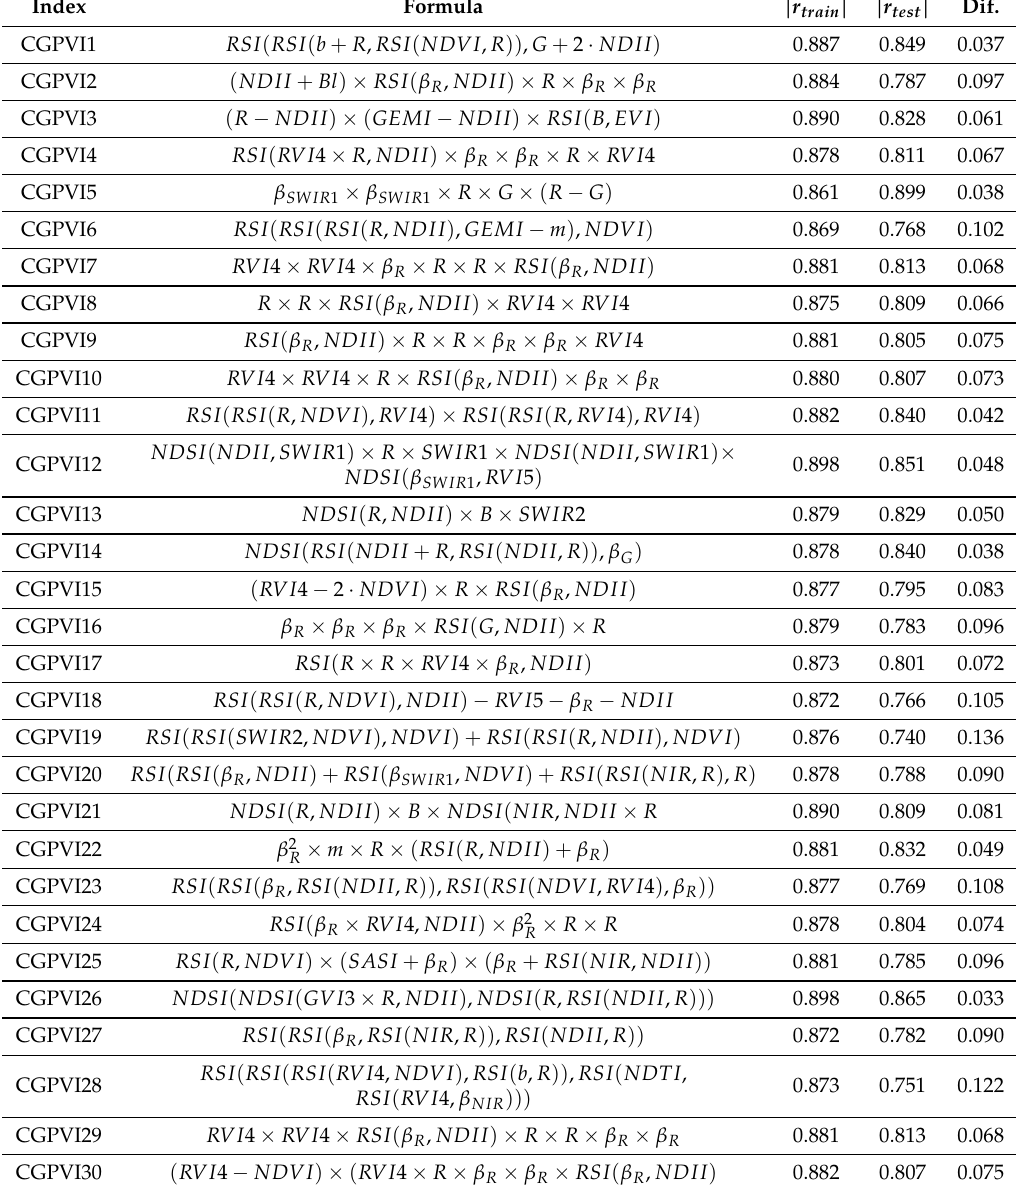
Table 6. Synthesized VIs for the GP method using the combined data from both watersheds. Performance was measured through the correlation factor ( | r x , y |